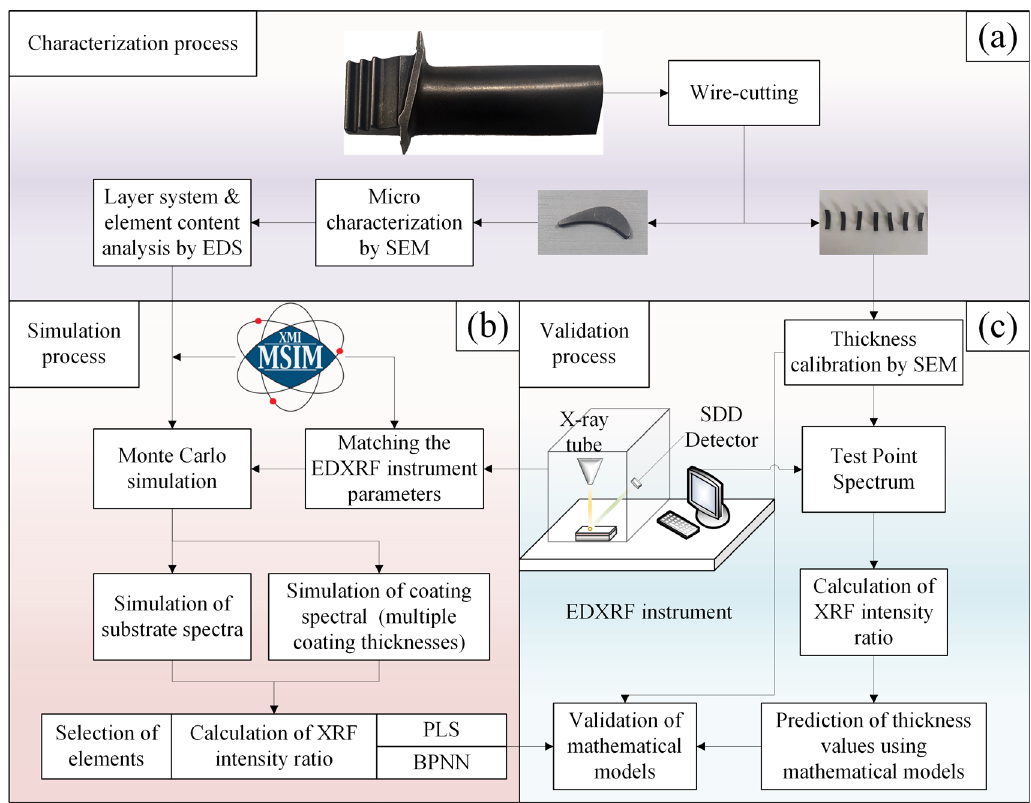
Figure 1. Flow chart of the characterization, simulation, and validation process. ( a ) Characterization process; ( b ) Simulation process; ( c ) Validation progress.